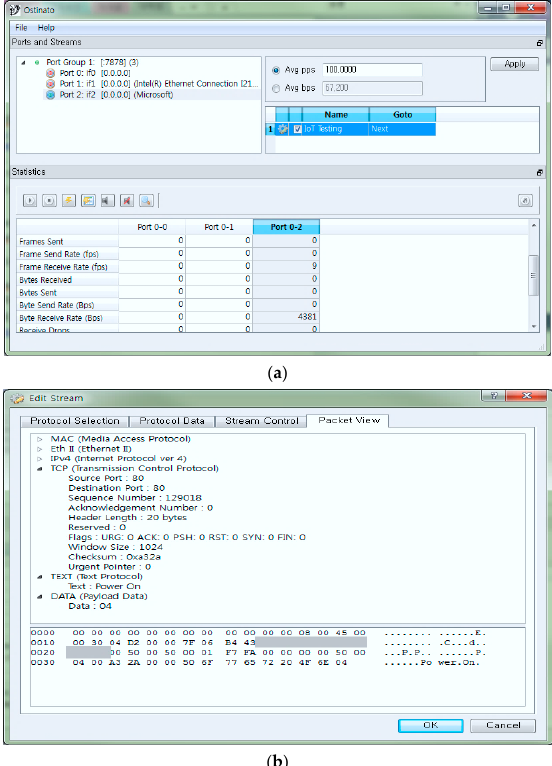
Figure 4. Ostinato settings environment ( a ) set up packet transmission and, ( b ) generate packets.